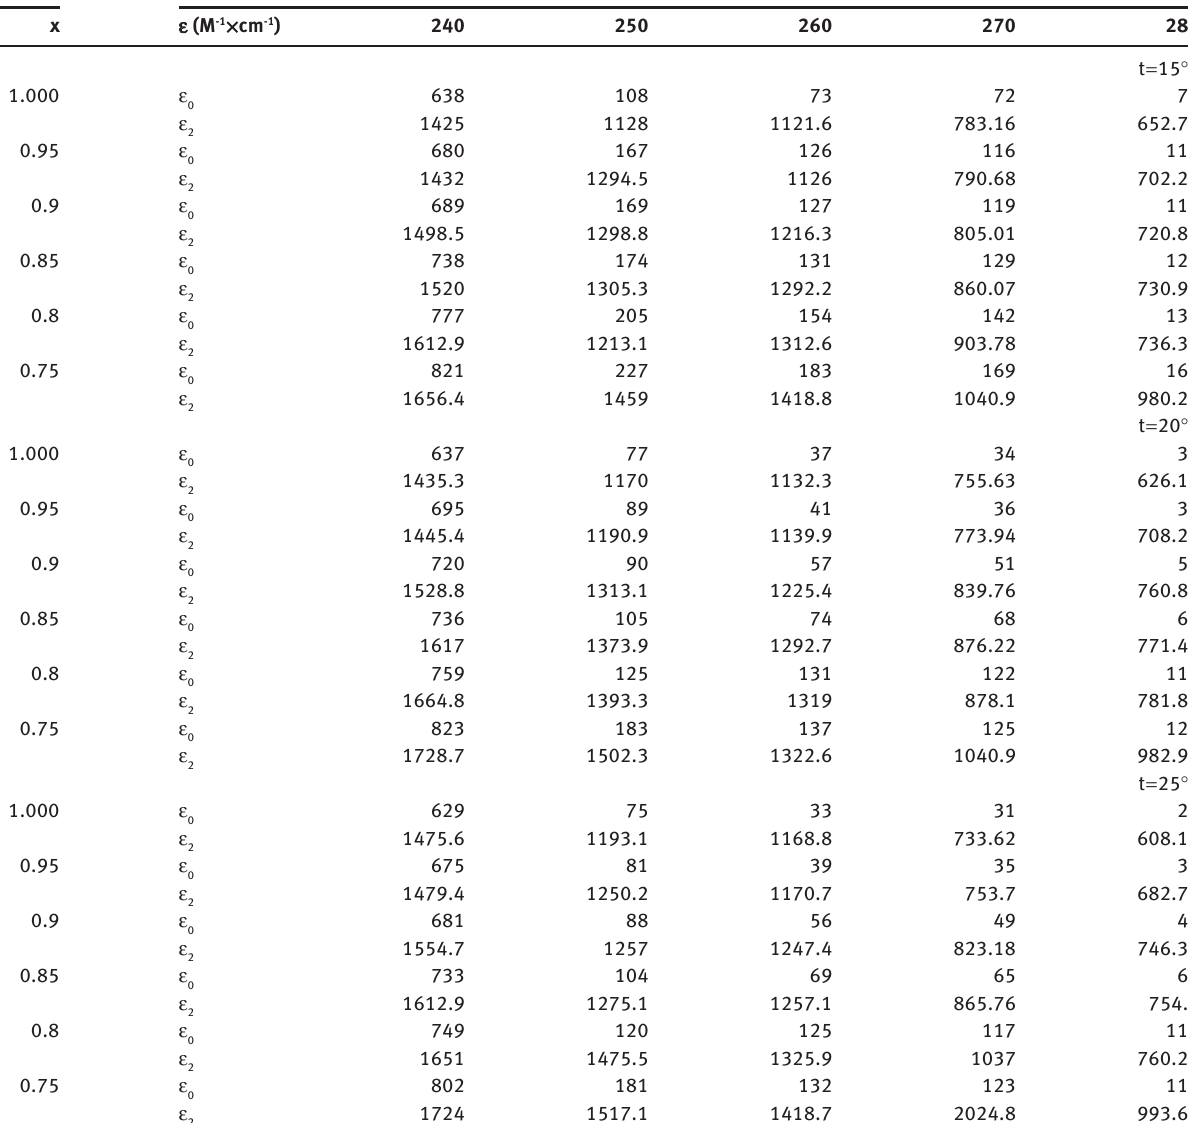
Table 2 Values of molar absorptivities of Al ( × 10 -4 ε I = 0.2 mol.dm -3